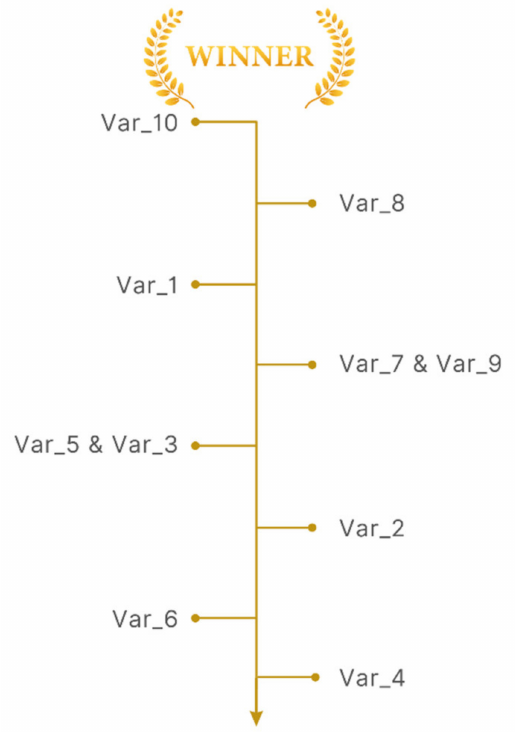
Figure 3. The final ranking of vehicle models from the point of view of the surveyed men.